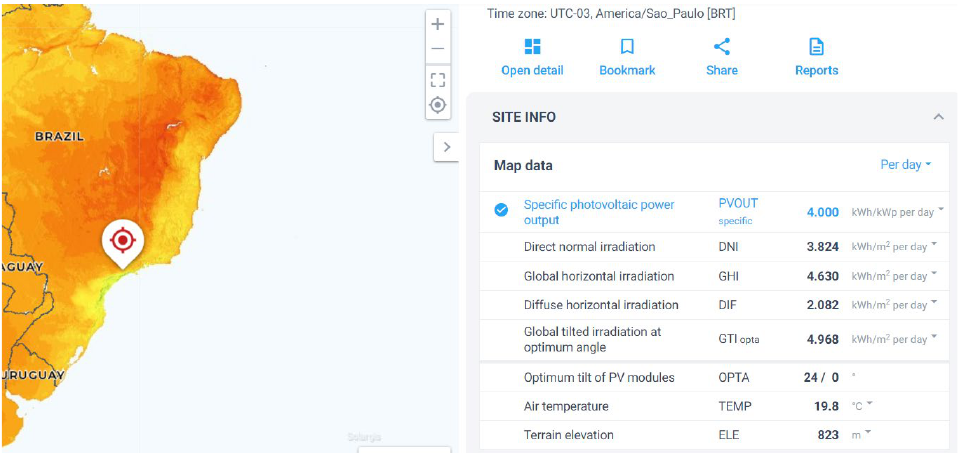
Figure 6. Solar irradiation data for the city of São Paulo, Brazil. Source: [50]. Finally, we estimated the total hourly radiation